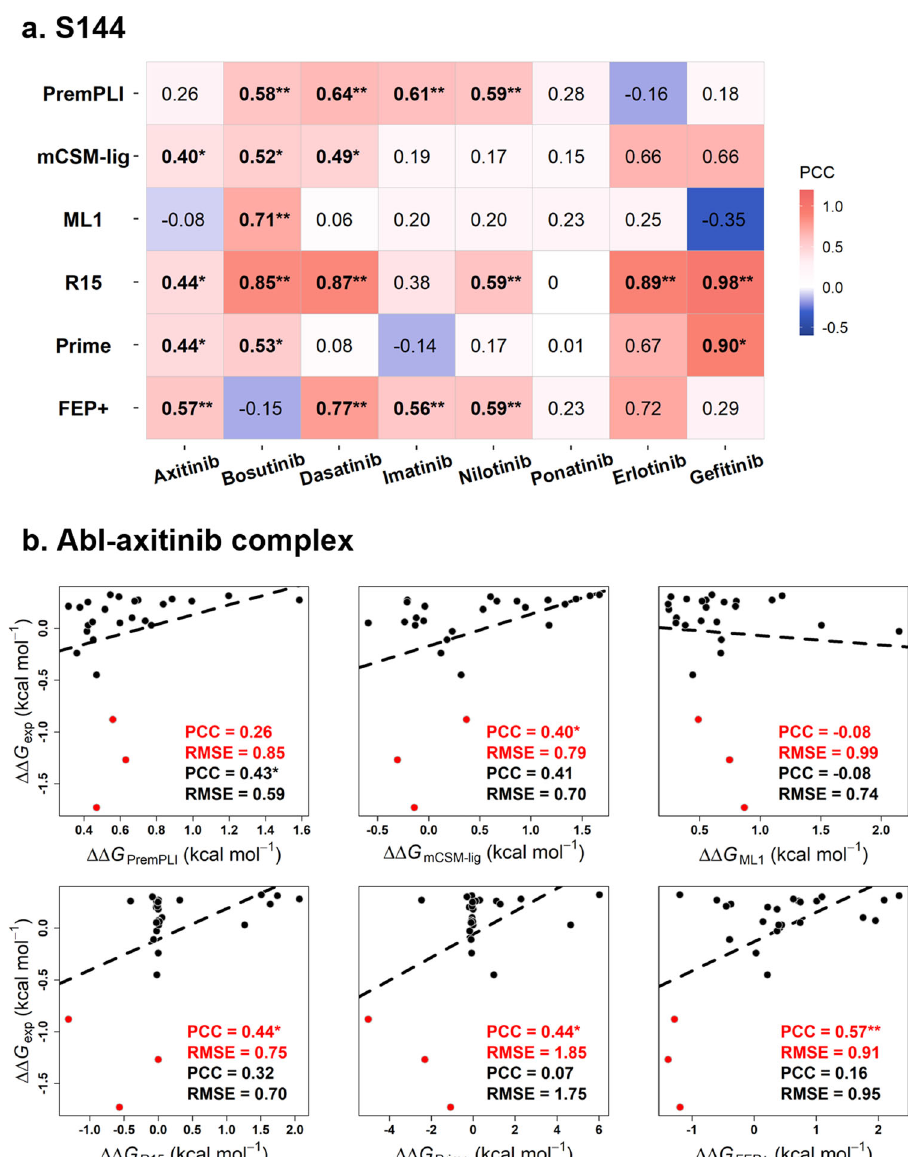
Fig. 5 Performance for different methods tested on tyrosine kinase inhibitors. a Pearson correlation coef fi cient for each tyrosine kinase inhibitor. * and ** indicate statistically signi fi cant difference from zero in terms of PCC with p -value < 0.05 and p -value < 0.01 ( t -test), respectively. b Performance of six different methods tested on Abl-axitinib complex. PCC and RMSE in red: all 26 mutations; PCC and RMSE in black: mutations with three red dots